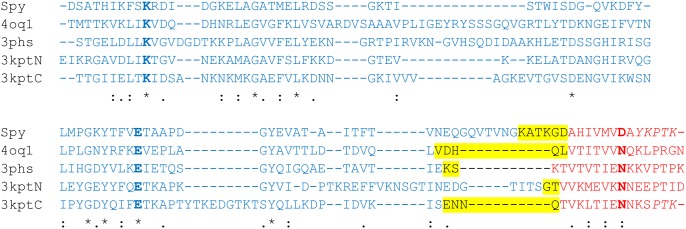
Structure-based multiple sequence alignment of the original Spy-system and the four constructs selected for the present study.The active site residues are shown in bold. Residues of the tag, catcher, and deleted regions are marked in red, blue, and yellow, respectively. A “*” marks a strictly conserved sequence position; “:” and “.” denote decreasing degrees of sequence similarity.